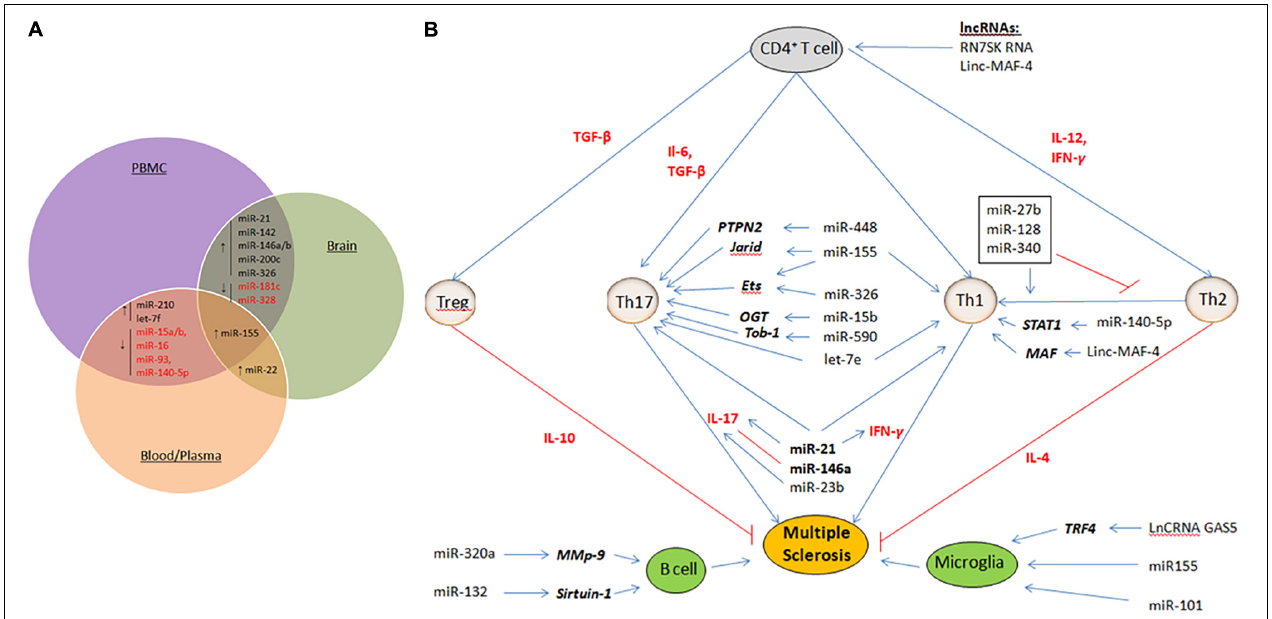
FIGURE 1 | (A) Dysregulated miRNAs that are common in various samples (PBMC, blood/Plasma and brain tissue) of MS patients. ↑ represent up-regulated miRNAs and ↓ represent down-regulated miRNAs. (B) Mechanisms of ncRNAs in MS. Shown are the miRNAs and lncRNAs that function in the modulation of various immune cells, including upregulating activity of the proinflammatory Th1 cells and Th17 cells, B cells, and Microglia cells. Aberant expression of such ncRNAs eventually results in demyelination within the brain and spinal cord, and axonal damage. Cytokines that promote cell fate and differentiation are shown in red. Target genes of miRNAs are shown in bold